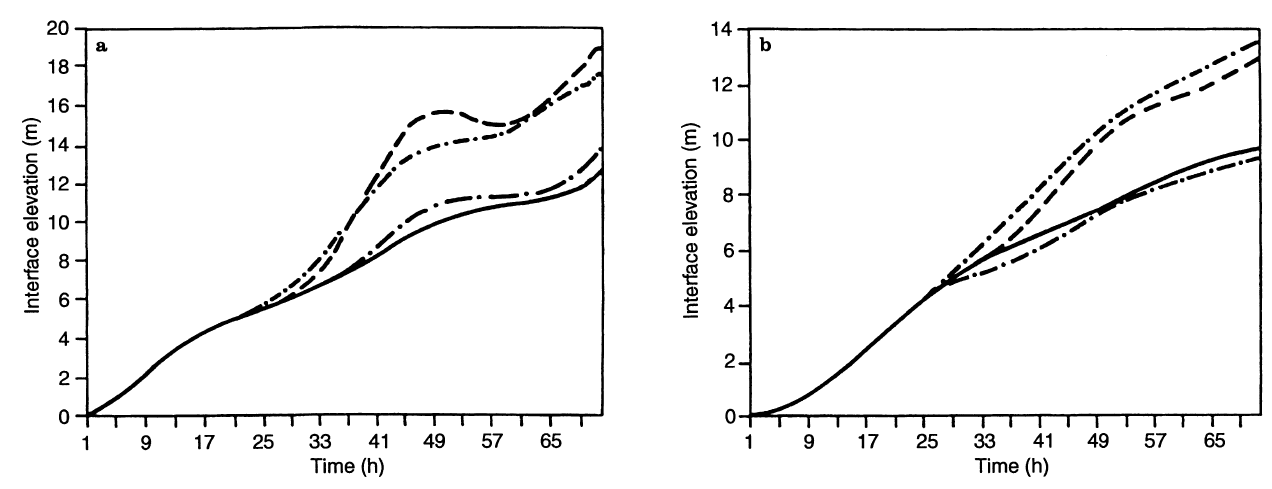
Fig. 16a,b. Time series of interface anomaly elevations obtained from the ocean model. a and b refer to summertime conditions and to grid points located near the coast in the vicinity of Cabo Frio and Cabo de Sa˜ o Tome´ , respectively. Solid line : constant NE wind; broken line : full